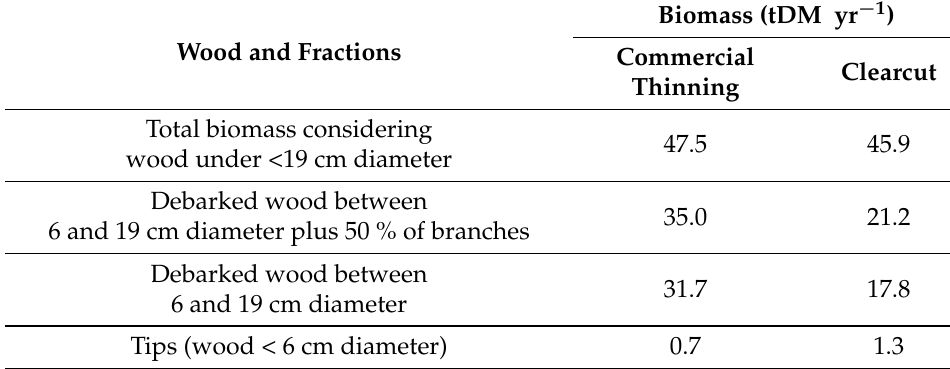
Table 6. Biomass coefficients applied for Eucalyptus grandis in the North region [41].